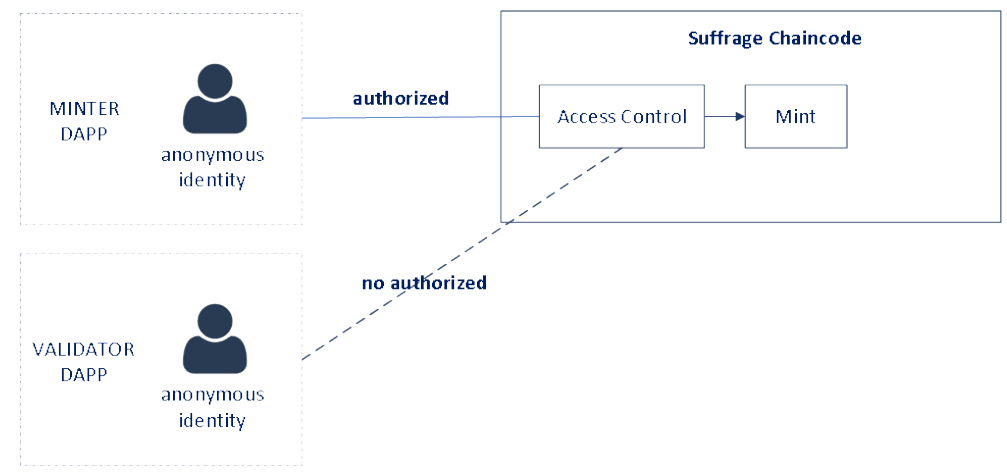
Figure 10. NFT Control Access.